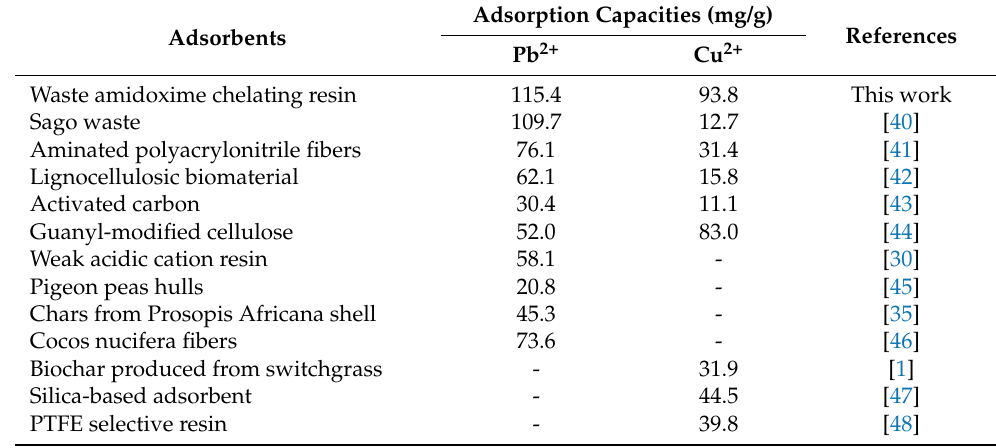
Table 5. Comparison of adsorption capacities of the WAC-resin and other adsorbents for Pb 2+ and Cu 2+